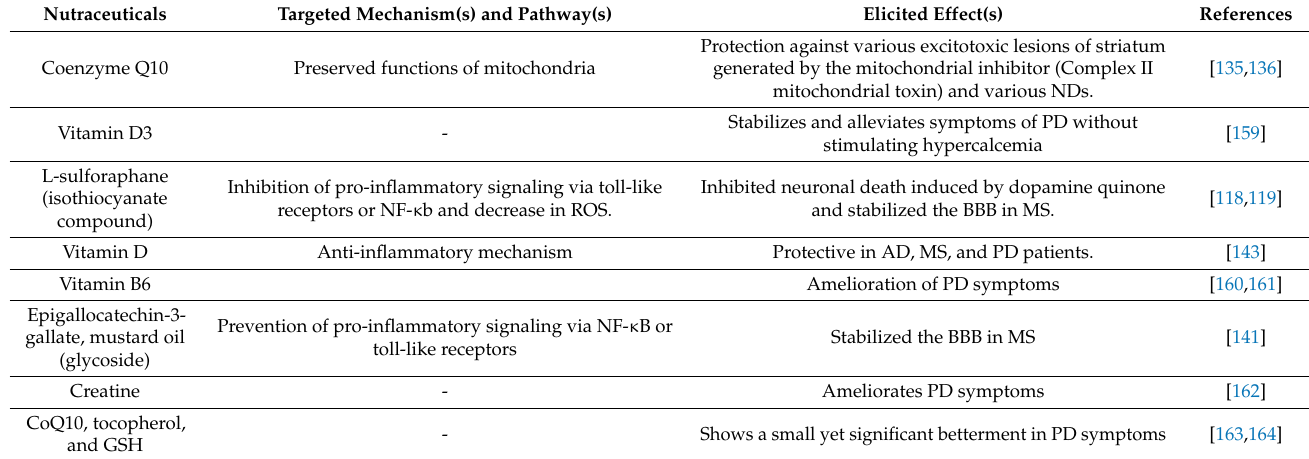
Table 1. Summary of nutraceuticals and their relevance in